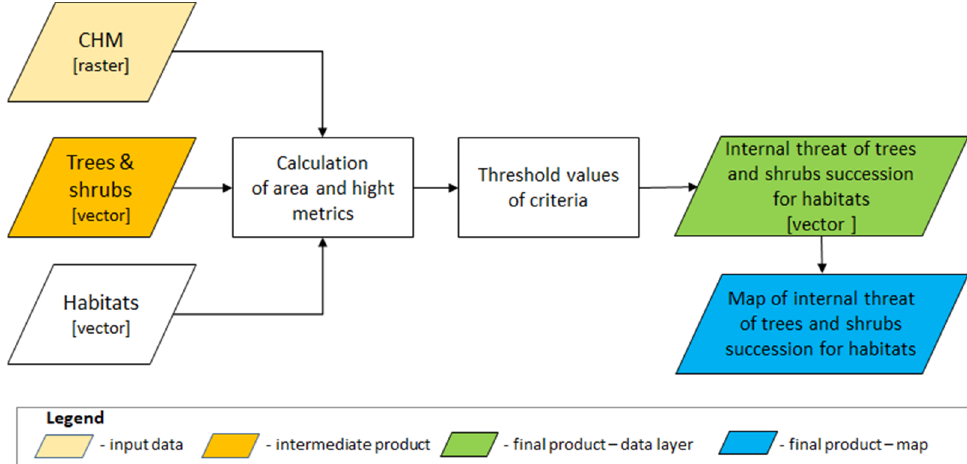
Figure 5. Scheme of the assessment of the level of internal threat for a habitat from the succession process.